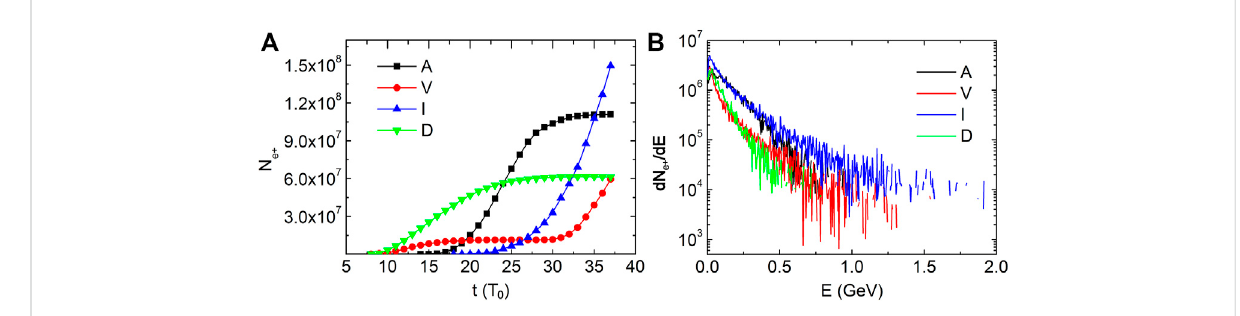
FIGURE 2 Evolutions of the positron yield (A) and spectra of positrons (B) at t (cid:2) 37T 0 in simulations with different types of